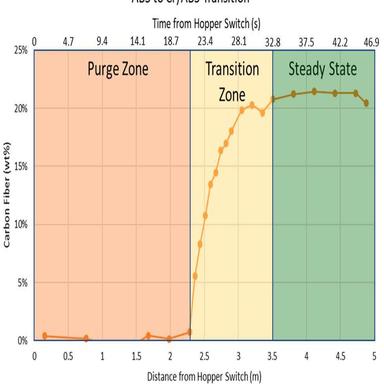
Fiber content vs both time (s) and distance (m) across the neat ABS to CF/ABS transition. Sampling rate was increased in the Transition Zone to improve resolution as fiber content rapidly increased.